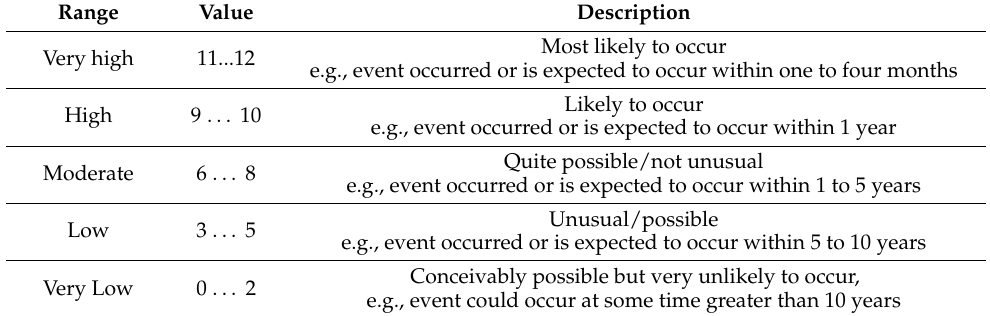
Table 13. Probability/likelihood of attack.